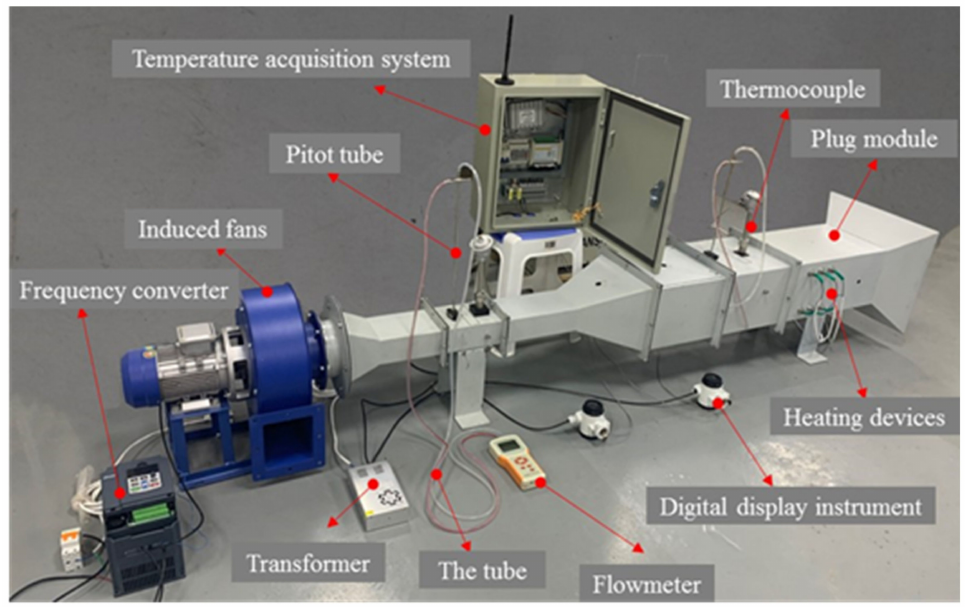
Figure 9. The composition of the test machine and its instruments.